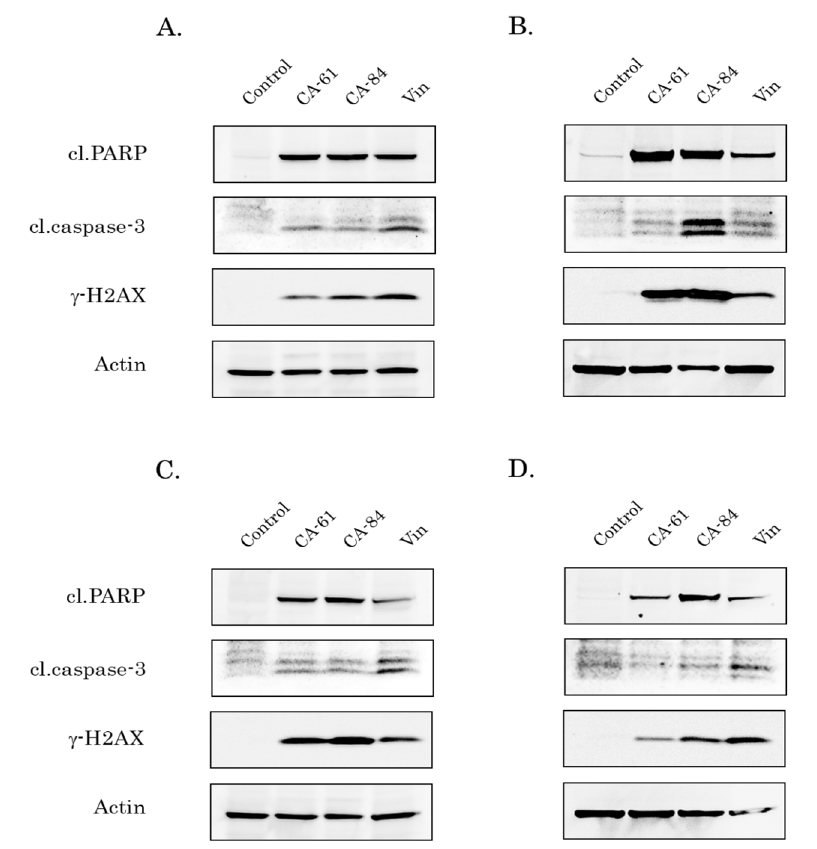
Figure 12. CA-61 and -84 induce apoptosis of epithelial cancer cell lines. Immunoblot analysis for apoptosis markers (cleaved forms of PARP and caspase-3), and γ -H2AX in HCC1806 breast cancer ( А ), MDA-MB-231 breast cancer ( B ), H1299 lung cancer ( C ), and PC-3 prostate cancer ( D ) cells after treatment with DMSO (negative control), CA-61, -84 (10 μ M), and Vinblastine (Vin) (0.01 μ M) for 48 h. Actin stain is used as a loading control.